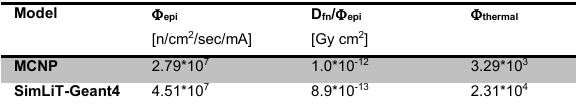
Table 4. Calculated values for neutron epithermal flux, ratio of fast to epithermal neutrons and thermal flux for a 7 Li(p,n) setup after moderation [24]. The Table compares values calculated with two main established transport codes (MCNP, GEANT4).